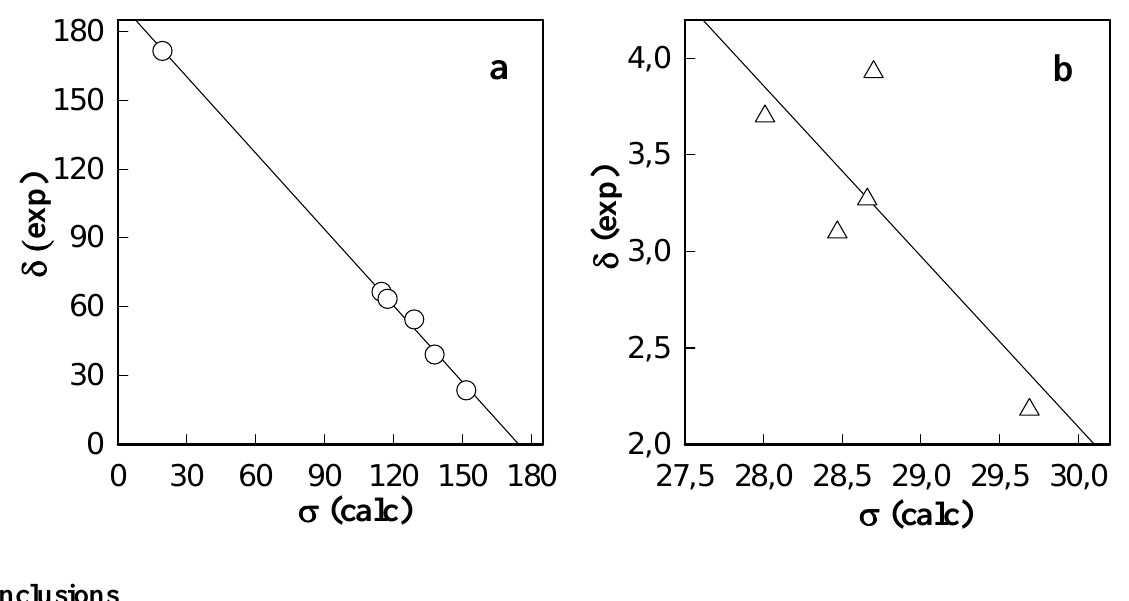
Figure 5. Experimental chemical shifts ( δ aminopropyl ammonium hydrochloride ( 2 ) vs. the isotropic magnetic shielding tensors ) from the GIAO/B3LYP/6-31G(d,p) calculations for molecules δ ( σ calc (a) 13 C and (b) 1